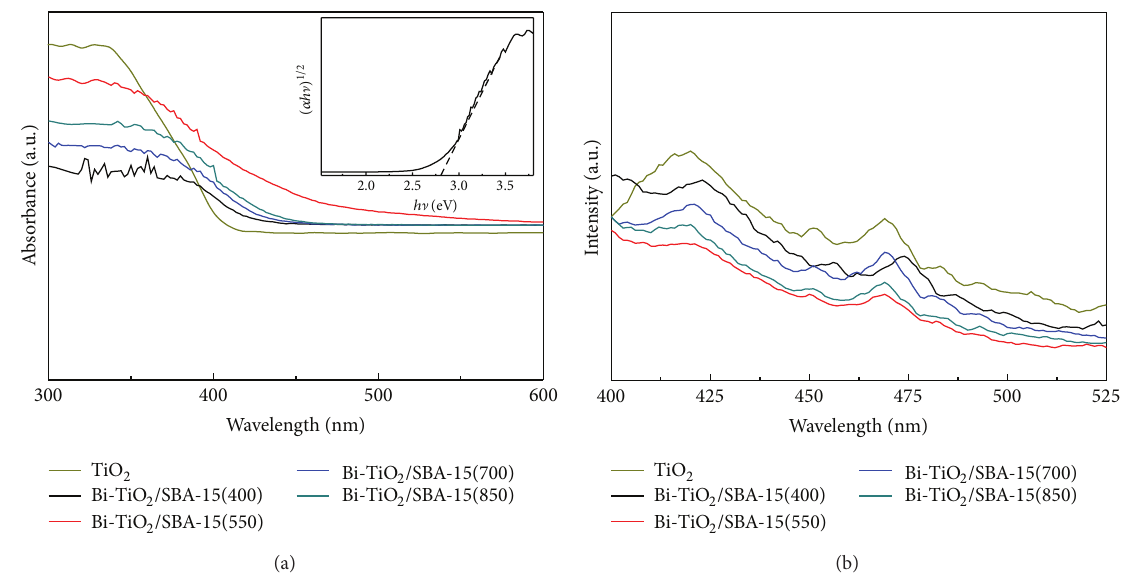
Figure 5: UV-Vis absorption spectra (a) and PL spectra of Bi-TiO 2 /SBA-15